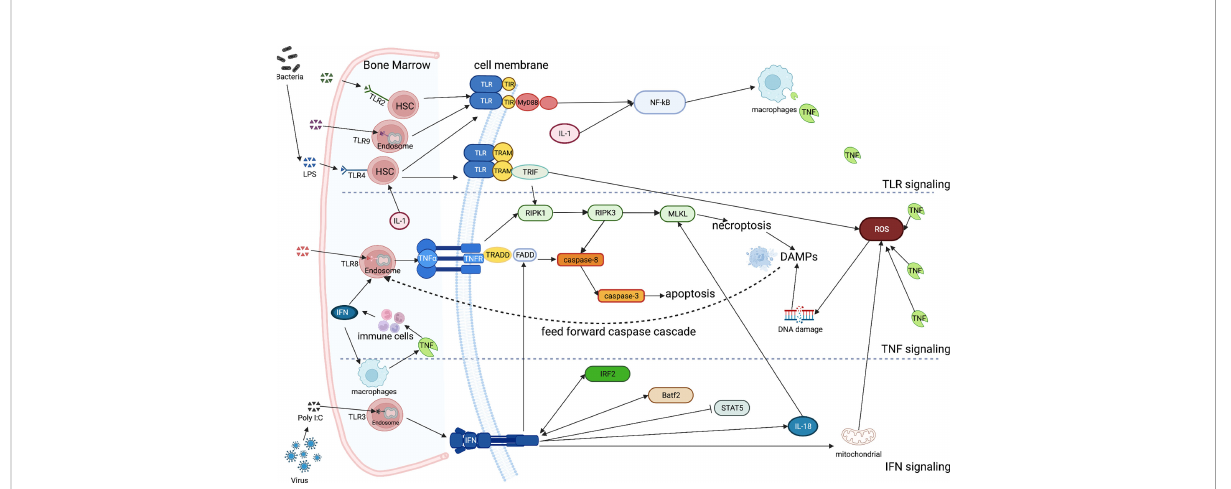
FIGURE 1 Simpli fi ed in fl ammatory signaling of TLR, TNF, IFN and ILs in bone marrow failure While most of the TLRs are located on the surface of HSCs, some others keep intracellularly (TLR3/8/9). They all directly sense the in fl ammatory stimuli and induce macrophages to release the excess of TNF through the toll-interleukin-1 receptor (TIR) and the myeloid differentiation primary response 88 (MyD88)-NF- k B pathway. IL-1 directly regulates HSC fate targeting also the NF- k B pathway. TLR4 can speci fi cally activate the TIR-domain-containing the adapter-inducing interferon- b (TRIF) via the TRIF-related adaptor molecule (TRAM) cross talking with the TNF signaling, paving the way for necroptosis trough the RIPK1/3- MLKL pathway. The products resulting from necroptosis constitute the DAMPs and feed-forward the caspase cascade. A large amount of TNF may also cause the accumulation of ROS, stimulating immune cells to release IFNs. After the activation of TNFR, TNFR1-associated death domain protein (TRADD) is bound, recruiting the adaptor Fas-associated death domain (FADD) triggering the caspase-8/3 receptor complex, inducing at the end apoptosis. The IFN signal, which is regulated by Irf2 and Batf2, leads also to apoptosis via the Fas pathway (FADD), being also perturb the phosphorylation state of STAT5. Moreover, IFN may also lead to an increased mitochondrial ROS, inducing DNA damage. Finally, IFNs are required for an increased in the compromising IL-18 expression, which mediates the MLKL-dependent cell death, compromising hematopoiesis during infection. (Created with BioRender.com).